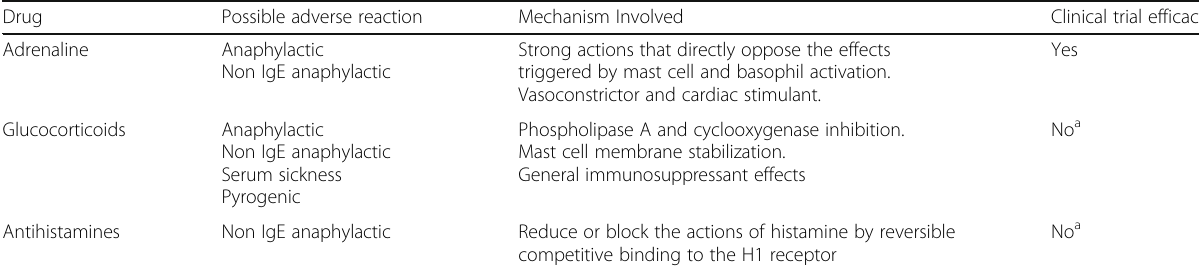
Table 2 Premedication used in antivenom treatment Drug Possible adverse